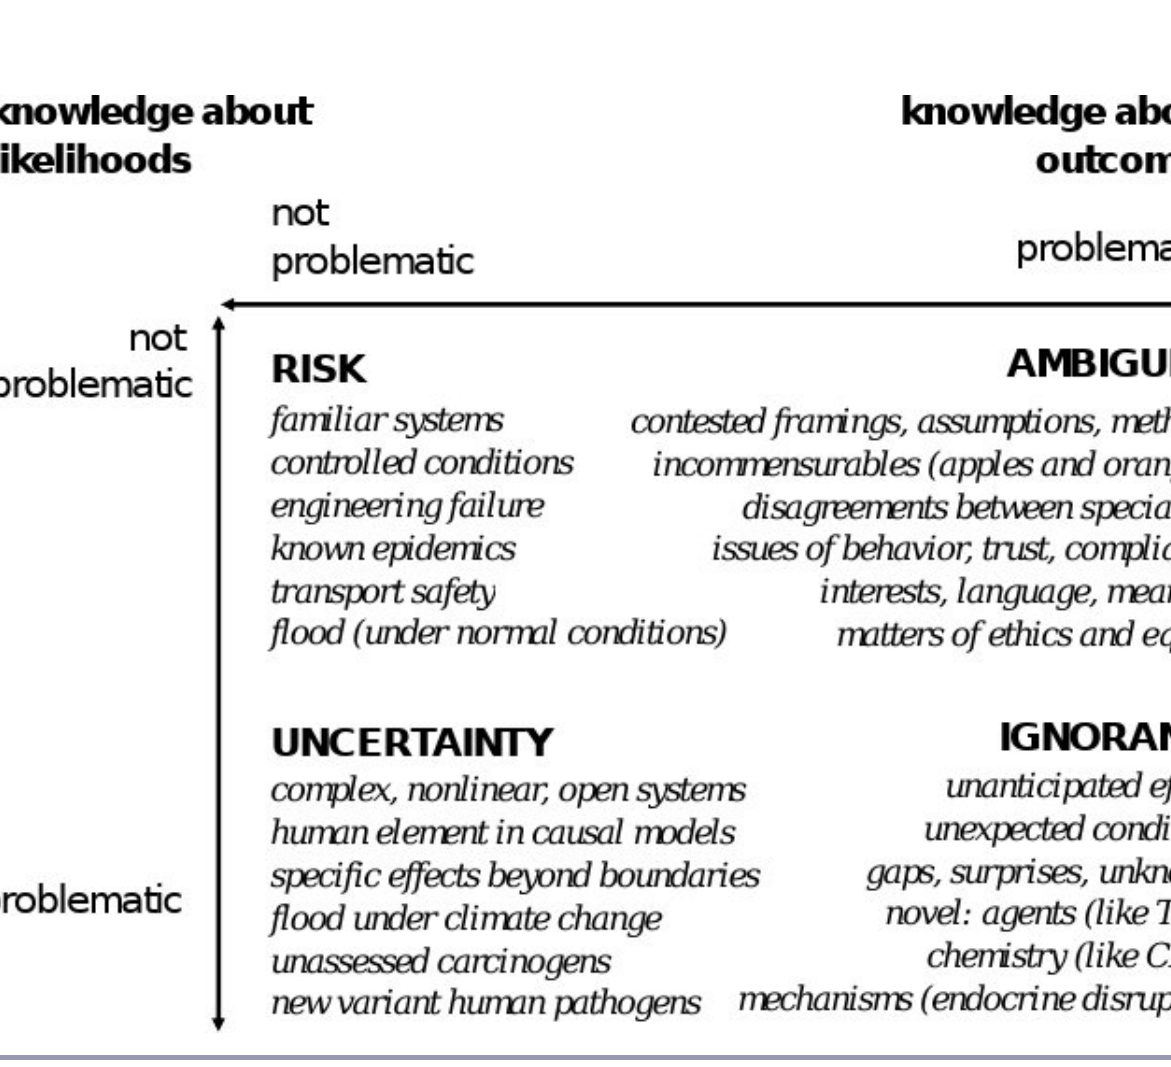
Figure 1. Contrasting states of incomplete knowledge, with schematic